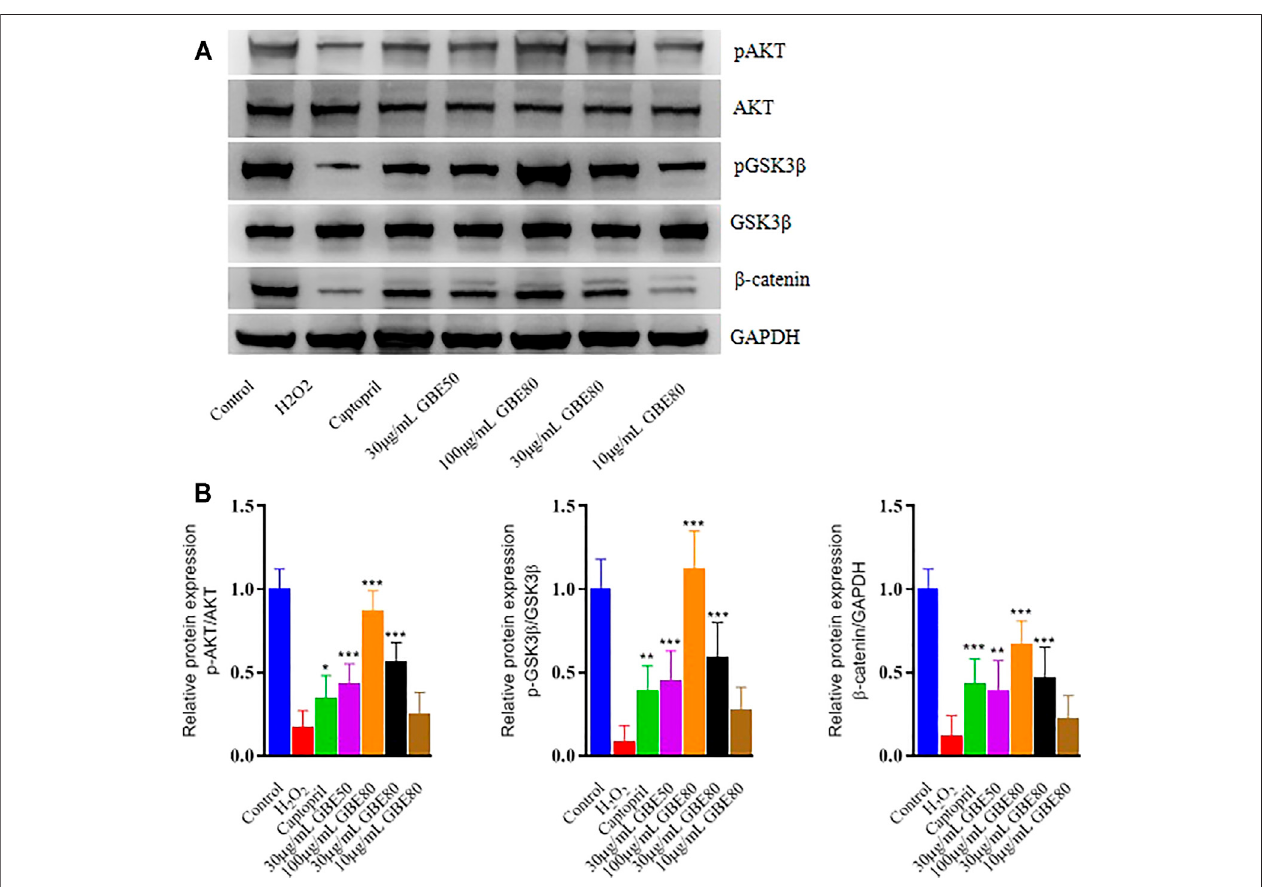
FIGURE 2 | Effects of different treatments under H 2 O 2 injury on the levels of pAKT, AKT, pGSK3 β , GSK3 β , and β -catenin. Western blotting (A) and densitometry analysis (B) of pAKT, pGSK3 β , and GAPDH in cardiomyocytes treated with H 2 O 2 and different treatment. (*, **, *** indicates p < 0.05, p < 0.01, p < 0.001 vs the H 2 O 2 group, respectively.)